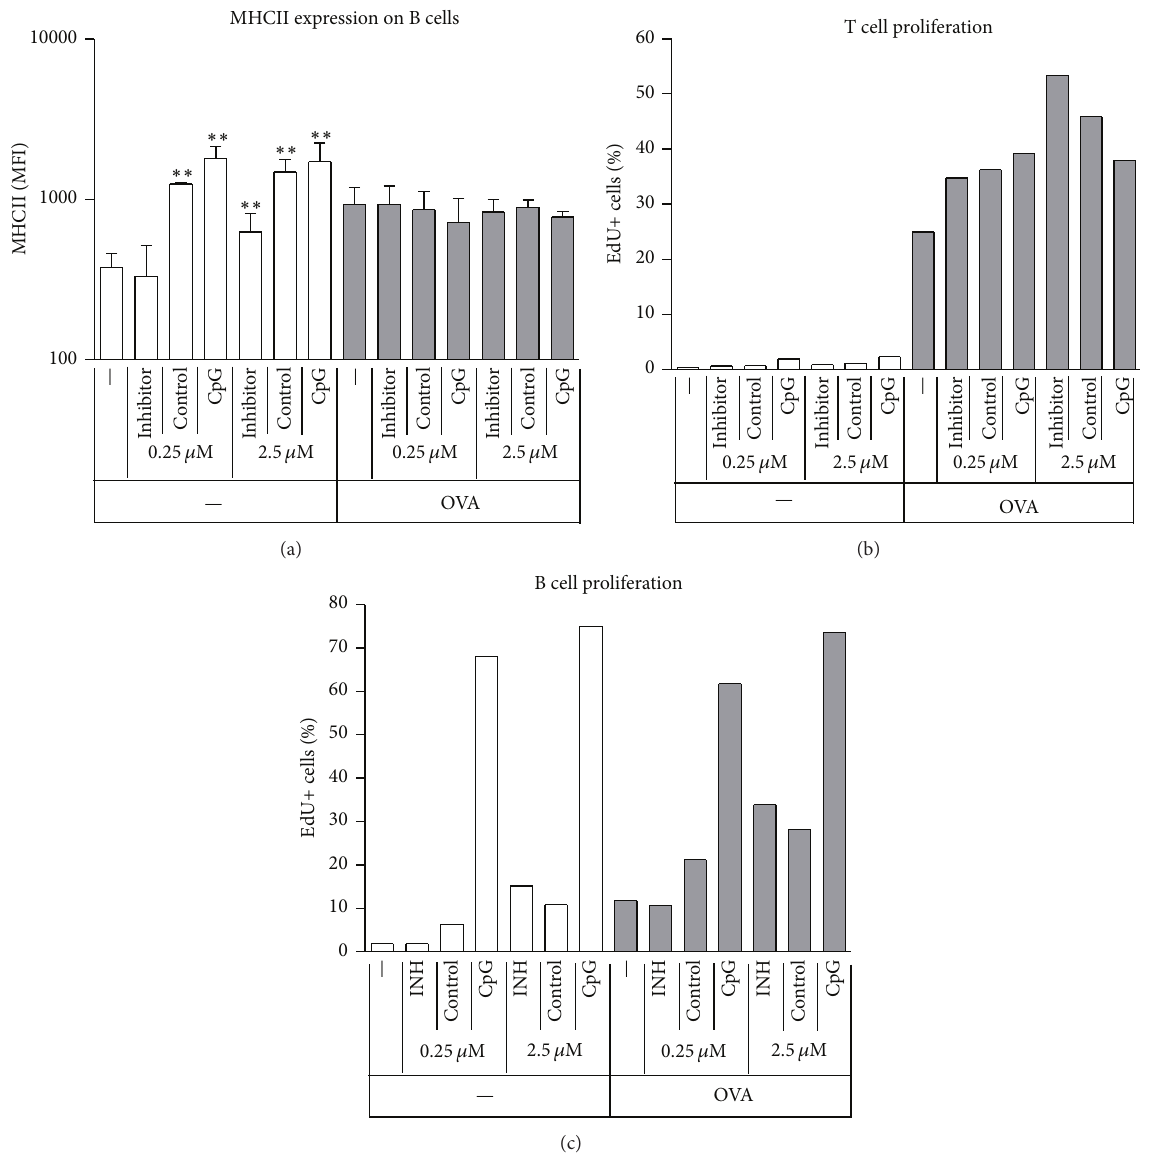
Figure 2: Effects of non-CpG ODN on late activation events. Spleen cells were incubated with the different combinations of ODNs and OVA as indicated. For MHCII expression measurements cells were harvested and stained for flow cytometry after 4 days (a). Medians and interquartile ranges of 9 independent experiments are shown. Asterisks indicate significant difference from the group receiving no ODN at all, within the respective OVA treatment group. MFI: mean fluorescence intensity; ∗ 𝑃 < 0.05 ; ∗∗ 𝑃 < 0.01 ; ∗∗∗ 𝑃 < 0.001 . For proliferation studies EdU was added on day 1 and left for incorporation for another day. The percentage of divided cells was then measured by flow cytometric analysis of EdU incorporation ((b), (c)). Results shown are from a single experiment; identical results were observed when EdU was added after 2